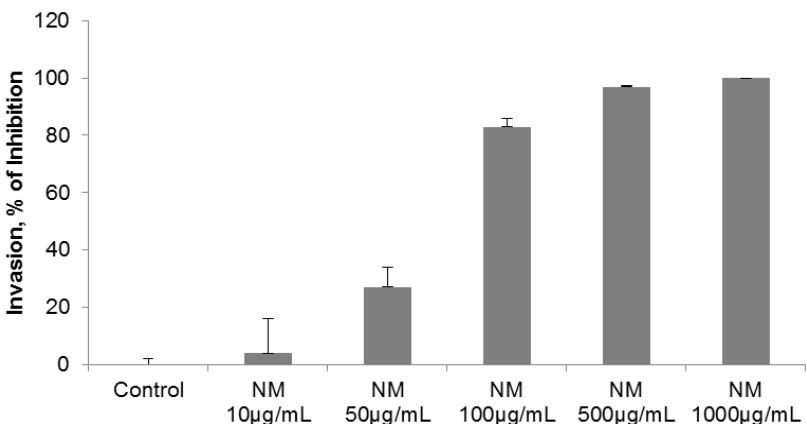
Figure 6. Effect of NM on HepG2 cell invasion through